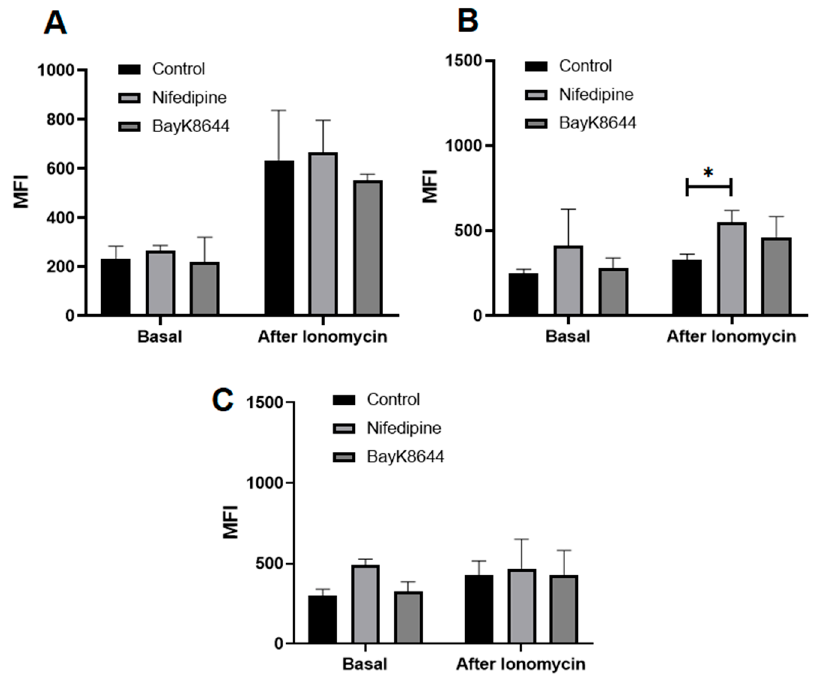
Figure 4. The effect of nifedipine and BayK8644 on the iCa 2+ levels in MenSCs ( A ), BMMSCs ( B ) and chondrocytes ( C ). Cells were treated with nifedipine (10 µM) or BayK8644 (10 µM) for the 24 h and stained with Cal-520 dye. The accumulation of iCa 2+ is shown as median fluorescence intensity (MFI) ± standard deviation (SD) before and 90 s after adding ionomycin (1 µM), measured by flow cytometer Calibur. * Data are shown as mean ± standard deviation (SD) and are significant at p ≤ 0.05 ( n = 3) measuring three different donor cells of each type, two-way ANOVA was